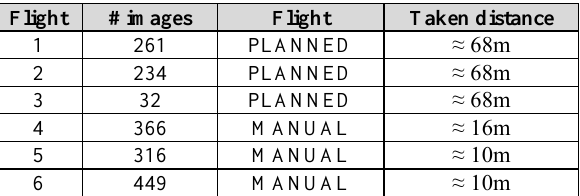
Table 2. Detail of UAV dataset